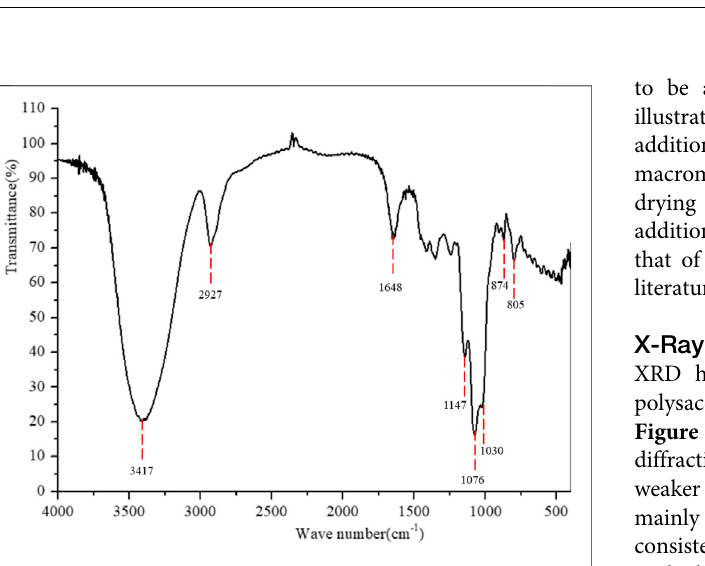
FIGURE 4 | Fourier-transform infrared spectroscopy spectrum of